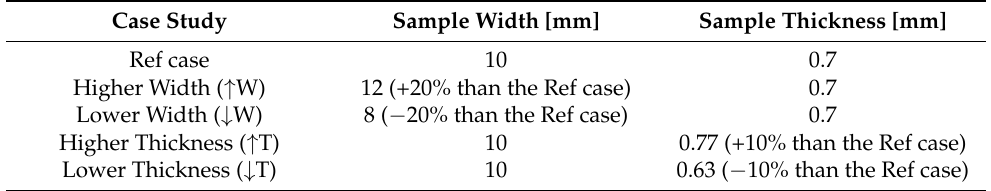
Table 1. Values used in the sample dimension case